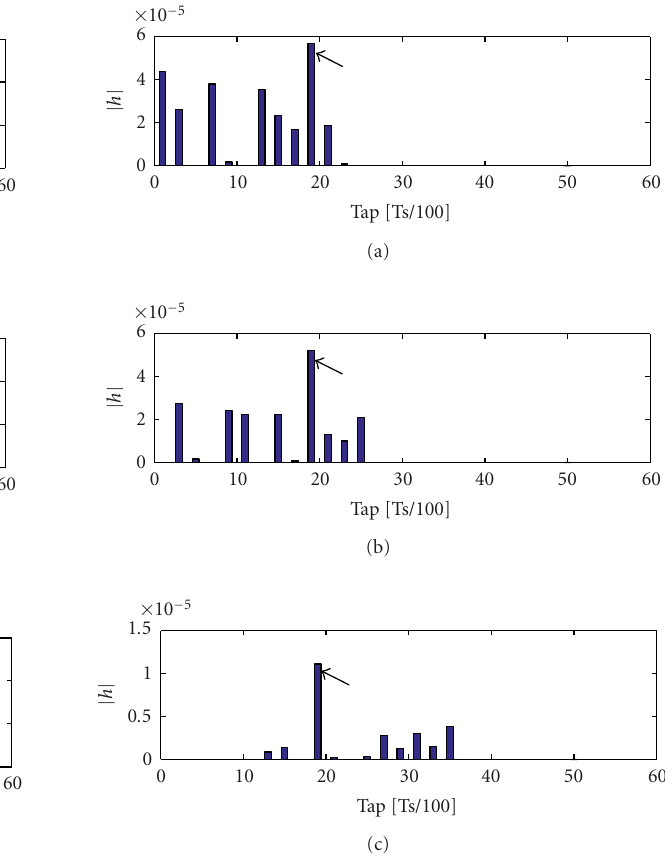
Figure 4: Impulse responses of the three relay channels after delay optimization in a typical urban